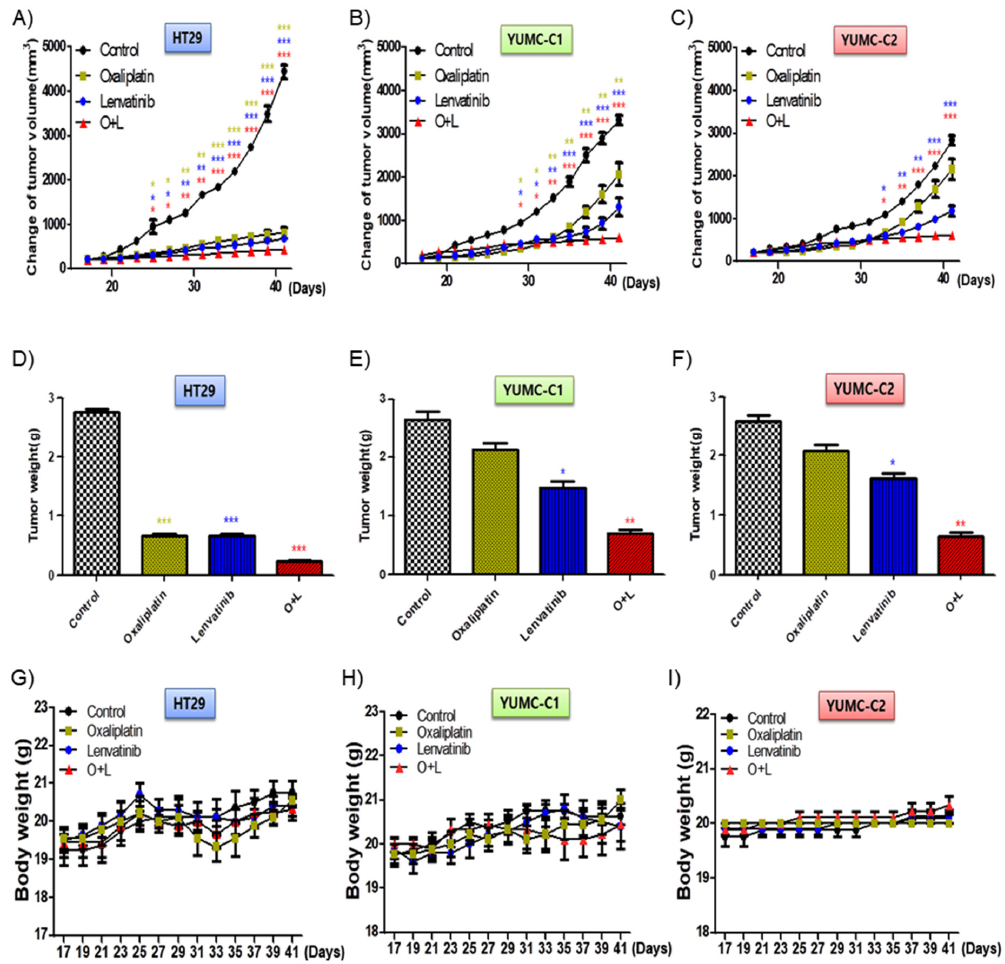
Figure 5. Cotreatment with oxaliplatin and lenvatinib induced a higher tumor shrinkage of cancer cell xenografts in vivo and inhibited tumor progression to a greater extent than treatment with either agent alone. Athymic nude mice with established tumors were treated with the indicated inhibitors. Data are the mean tumor volumes. The inhibition of tumor progression of HT-29 ( A , D , G ), YUMC-C1 ( B , E , H ), and YUMC-C2 ( C , F , I ) cell-induced tumors treated with agents alone or in combination. ( A – C ) Change in tumor volume, ( D – F ) weight of dissected tumors, and ( G – I ) compounds had no significant e ff ect on mouse body weight. * p < 0.05, ** p < 0.01, and *** p < 0.005 compared with